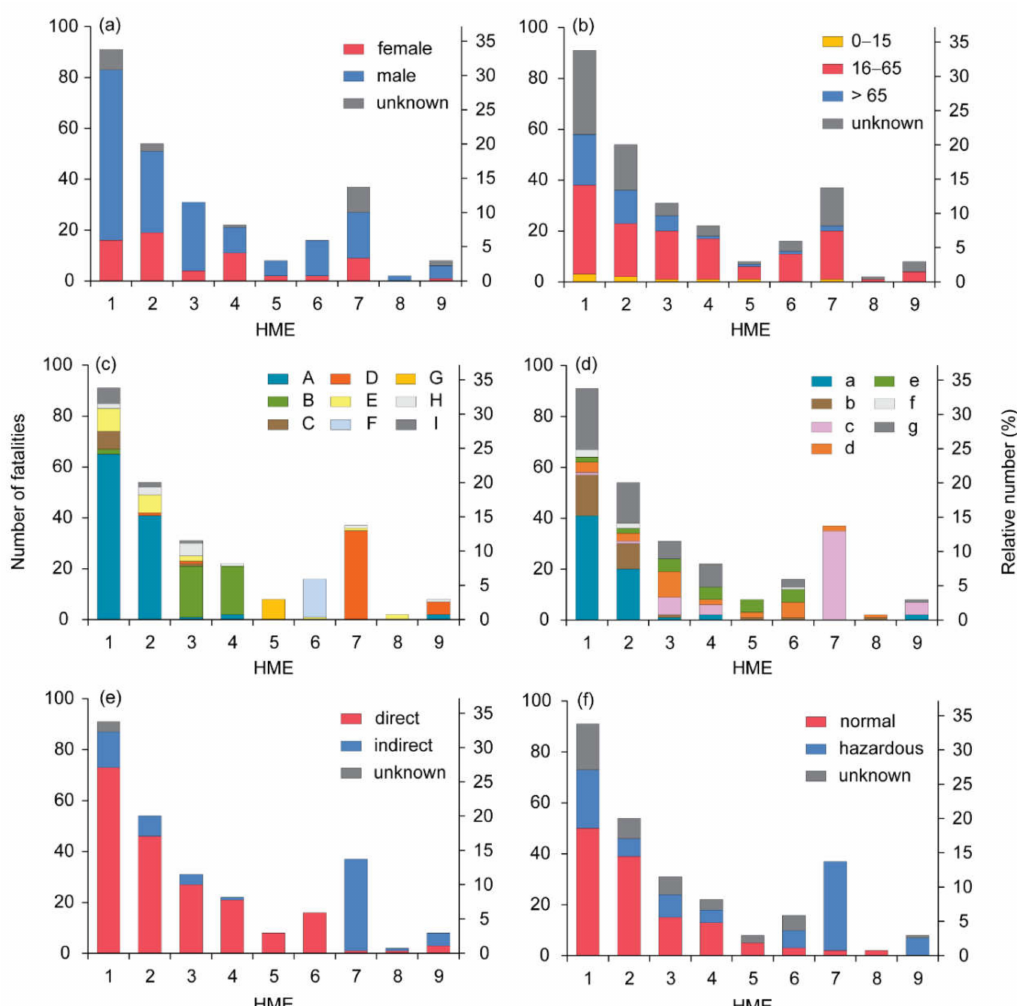
Figure 8. Characteristic features of fatalities expressed by their absolute and relative